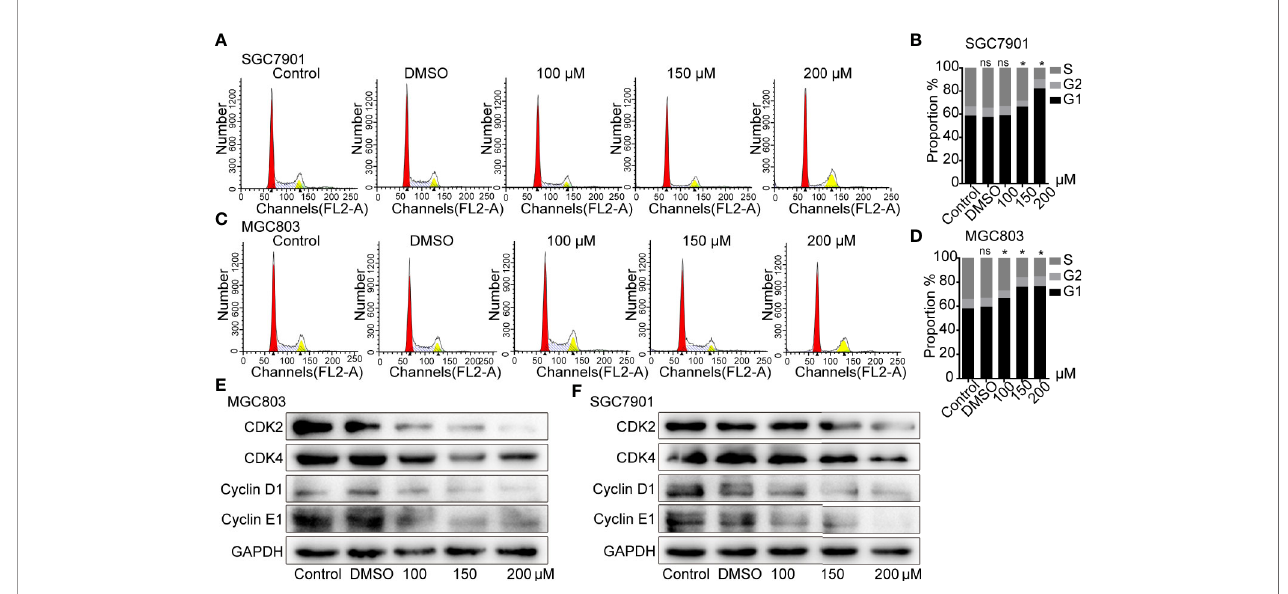
FIGURE 2 | Germacrone induced G0/G1-phase cell cycle arrest in gastric cancer cells. (A – D) Propidium iodide (PI) staining was used for fl ow cytometric (FCM) analysis of the effect of germacrone on the cell cycle. (E, F) Western blot was used to detect changes in the expression levels of CDK2, CDK4, cyclin-D1, and cyclin- E1. Data are the means ± SD of three experiments. * P < 0.05; ns, not signi fi